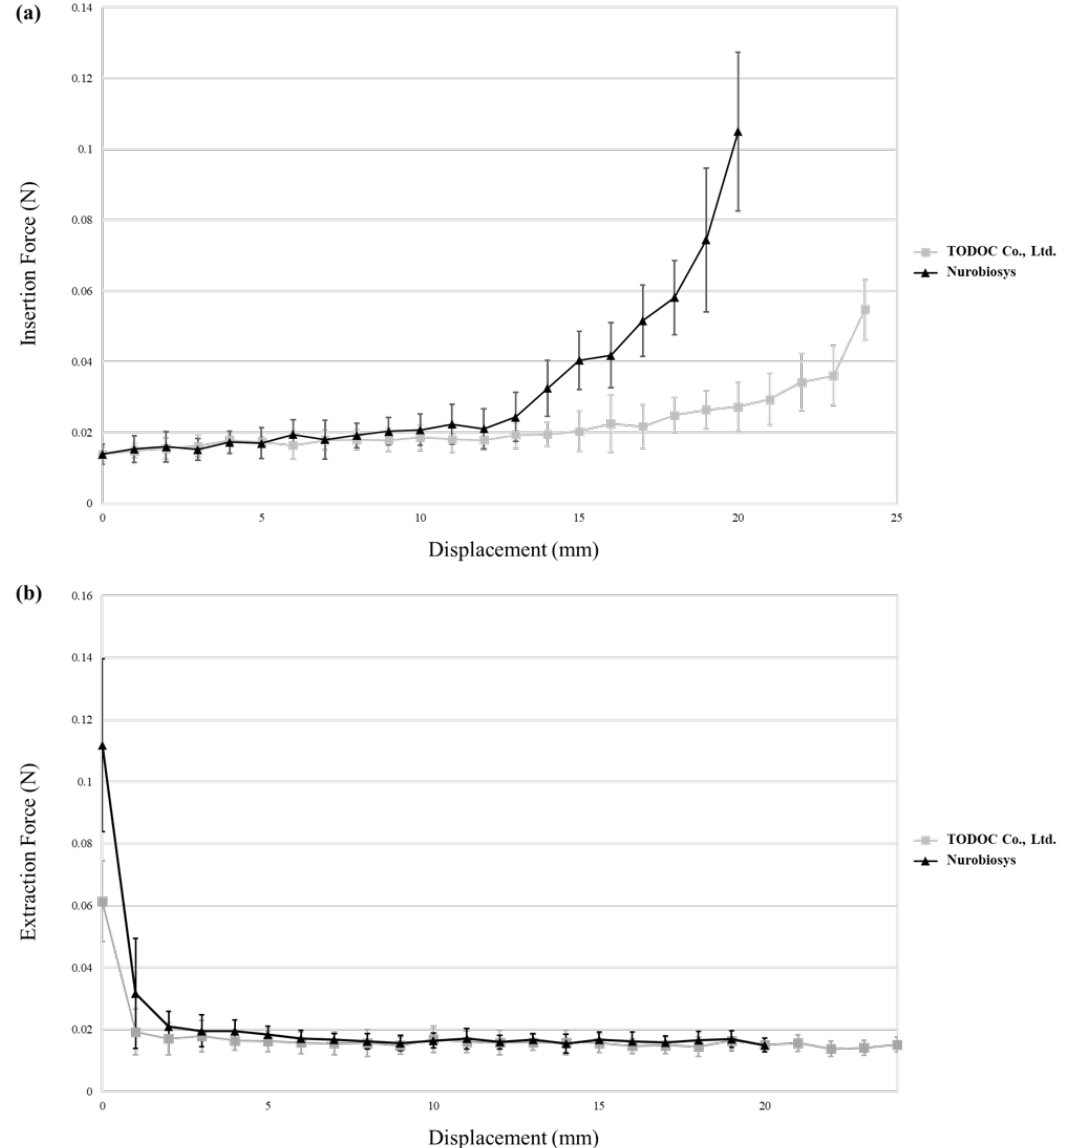
Figure 6. ( a ) Insertion and ( b ) extraction force measurements. Average and standard deviation of measured values are